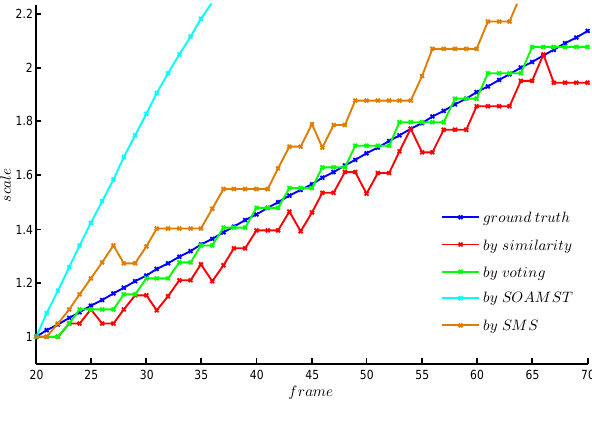
Figure 7. The determined scale factors estimated by the 4 methods comparing to the ground truth.